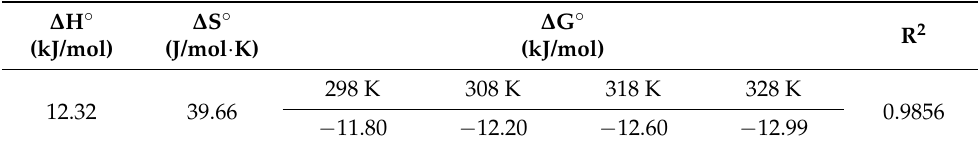
Table 4. Thermodynamic parameters for adsorption of Sc(III) onto